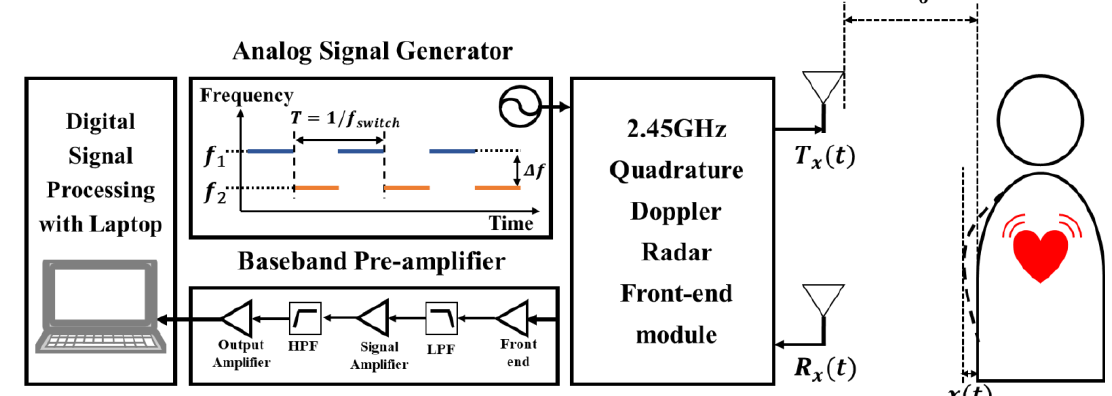
Figure 1. Block diagram of the proposed frequency-shift keying (FSK) radar.